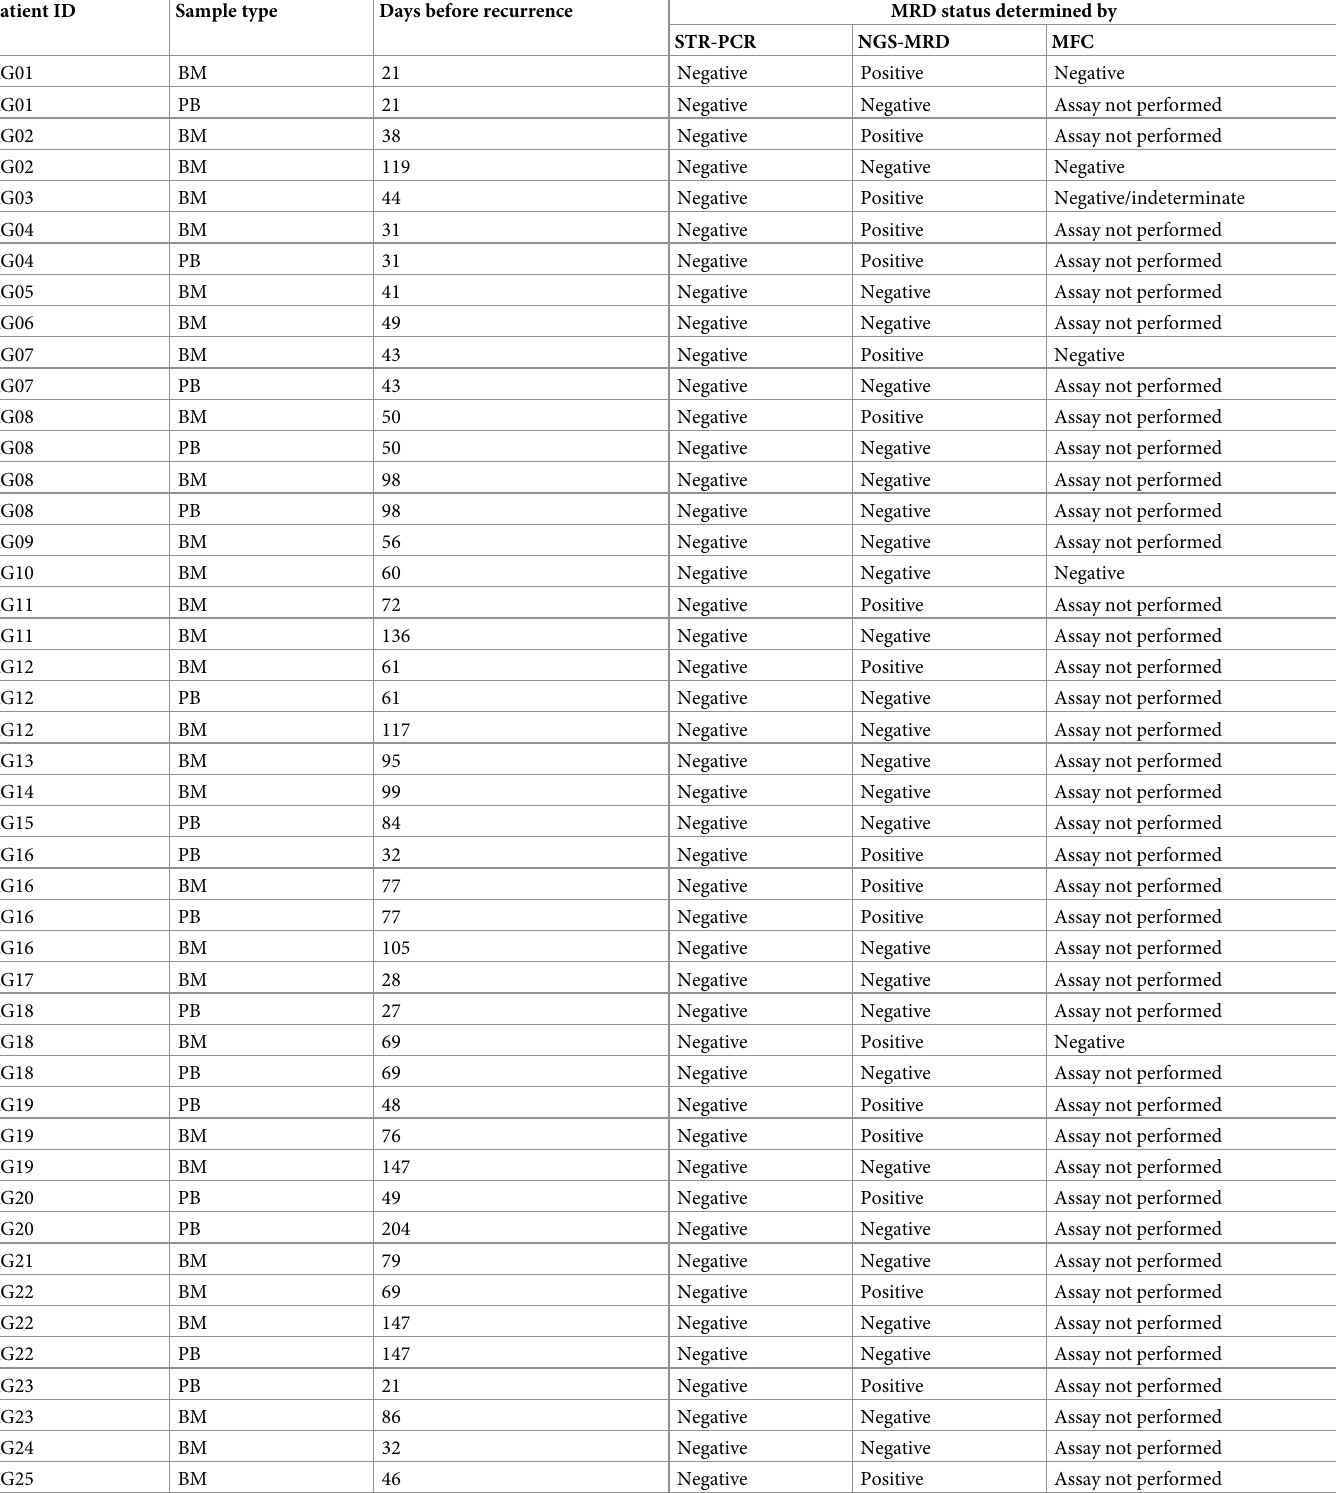
Table 2. MRD status for all the samples used in this study determined by three different assays. Patient